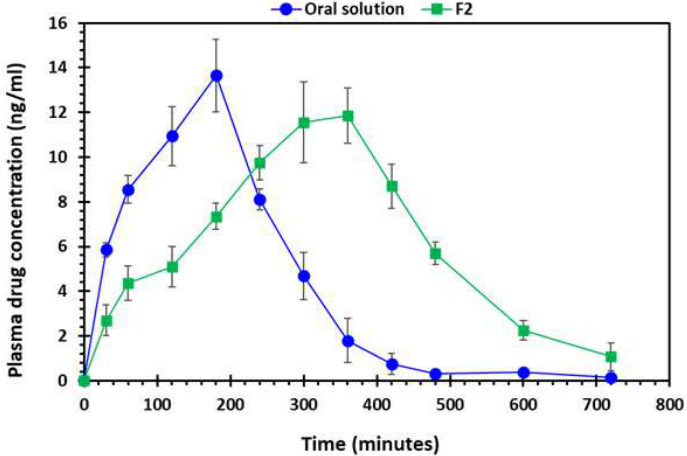
Figure 12. Plasma drug (gabapentin) absorption vs. time profile of oral solution and 3D-printed tablet, F2 (2 shells with 0% infill), n = 6. Table 5. Pharmacokinetic parameters of gabapentin solution and 3D-printed tablet (F2, 2 shells with